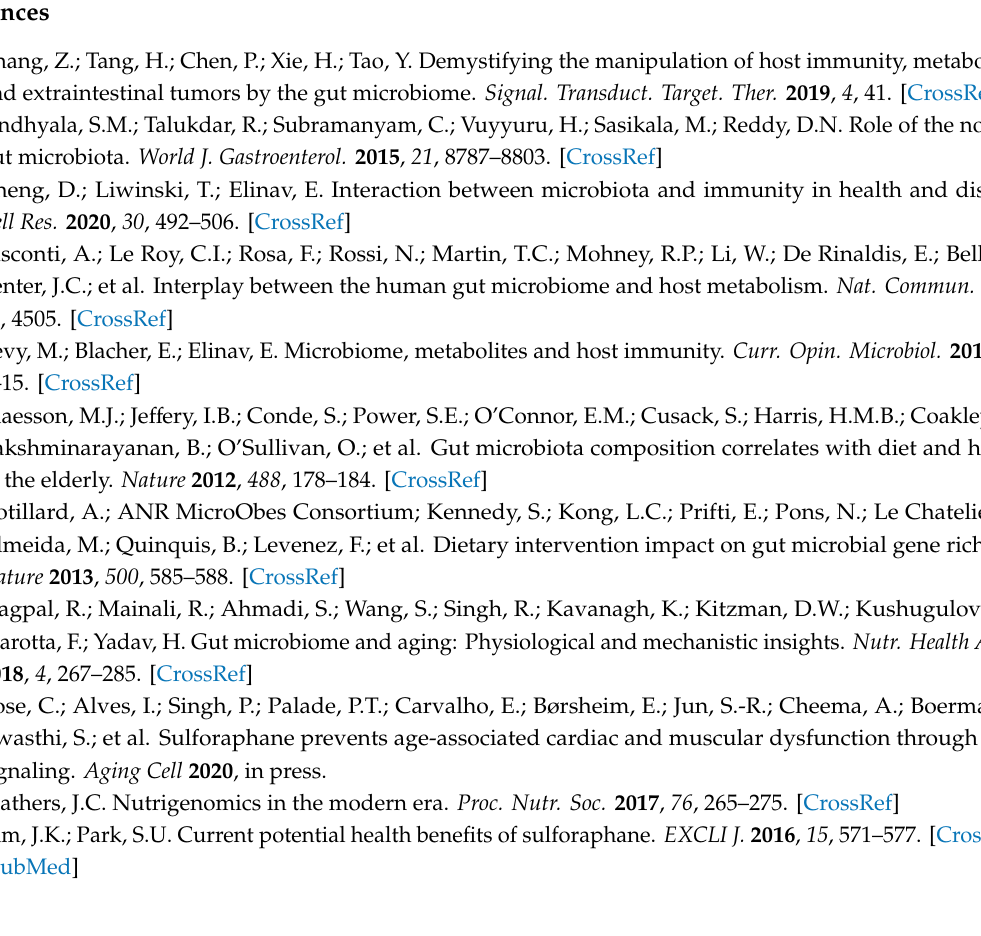
Figure S1. Identification of bacterial biomarkers using linear discriminant e ff ect size analysis. Figure S2. MIMOSA analysis results. Figure S3. The log-transformed concentration profiles of well-predicted metabolites by MelonnPan in Figure 7. Table S1. Alpha diversity significance test. The Kruskal–Wallis test was used to calculate p -value between experimental groups for phylogenetic diversity index and species richness. A p -value < 0.05 is flagged with an asterisk. Table S2. Beta-diversity significance test. The p -values of significant di ff erences in beta diversity between experimental groups were calculated using permutational multivariate analysis of variance (PERMANOVA) with 999 Monte Carlo permutations. A p -value < 0.05 is flagged with an asterisk. Table S3. List of 61 metabolites identified by